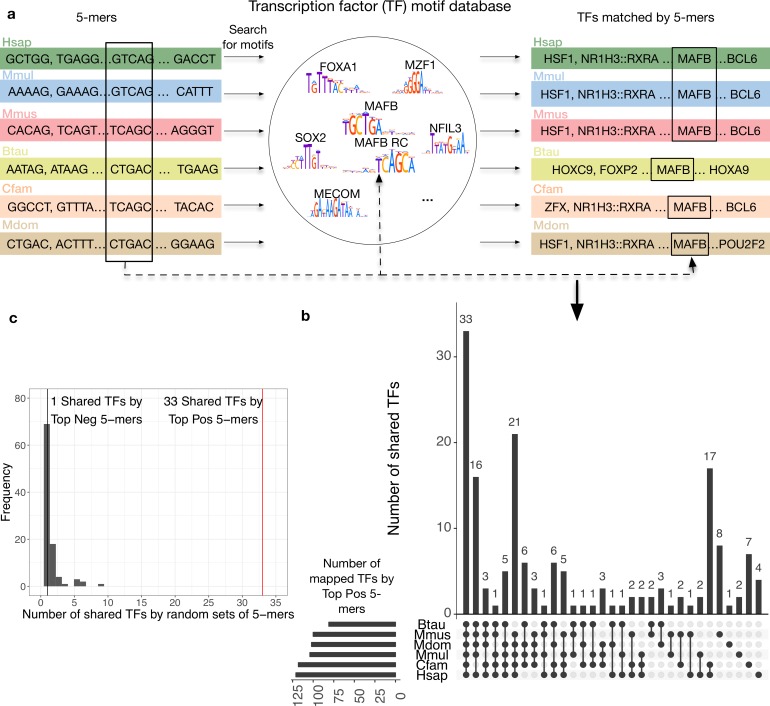
The DNA sequence patterns most predictive of liver activity across species matched a common set of transcription factors.(a) Transcription factor analysis workflow. For each species enhancer classifier, we found TF motifs matched by the top 5% positively weighted 5-mers. Note that different 5-mers (marked with black box on the left) can match the same motif, e.g., MAFB and its reverse complement (RC). The overlap of matched TFs were then compared across each species’ classifier. (b) 33 of the TF motifs matched by the top 5% positive 5-mers from each GC-controlled liver classifier are shared in all species. The total number of TFs matched by top 5-mers in each species was: 121 (human), 104 (macaque), 100 (mouse), 81 (cow), 118 (dog), 102 (opossum). Similar results were observed for the non-GC-controlled classifier (S20 Fig). (c) The number of TFs matched by all species based on 5-mers in top positive, top negative, and 100 random sets of 5% of all possible 5-mers. The 33 TF motifs shared among the high-weight set for each species is thus significantly more than expected.